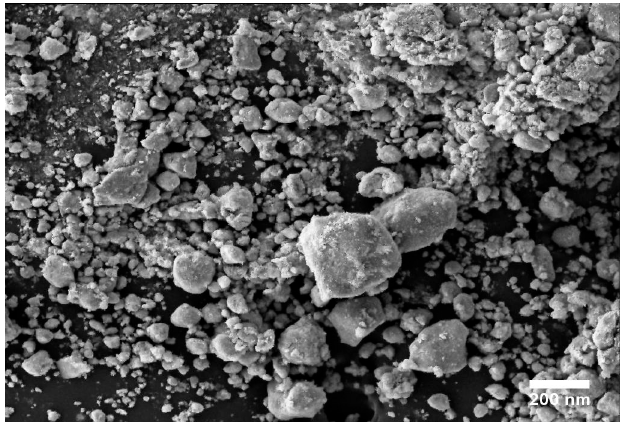
Figure 1. SEM image of zinc oxide nanoparticles (NPs).